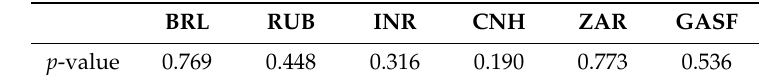
Table 4. Bai–Perron breakpoint test on return series.